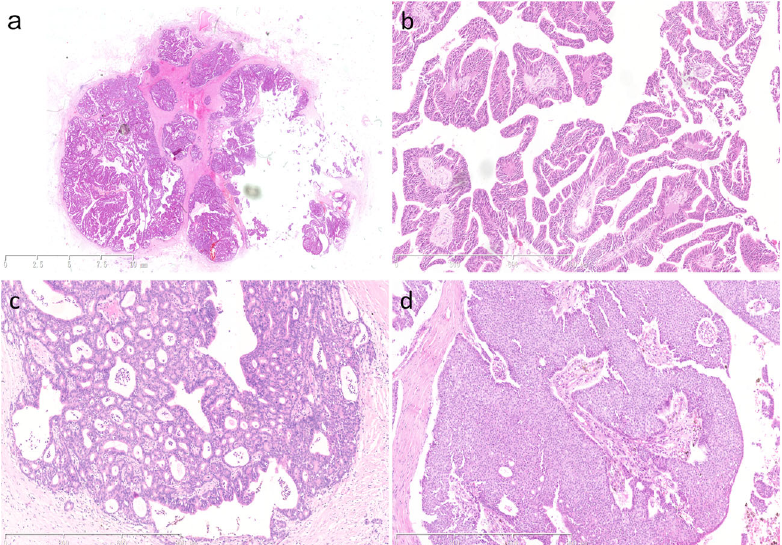
Fig. 1 Histopathological features of EPCs. a A scan of an EPC in a low power fi eld (4×). b Papillary structure (100×, H&E staining). c Cribriform structure (100×, H&E staining). d Solid structure (100×, H&E staining).